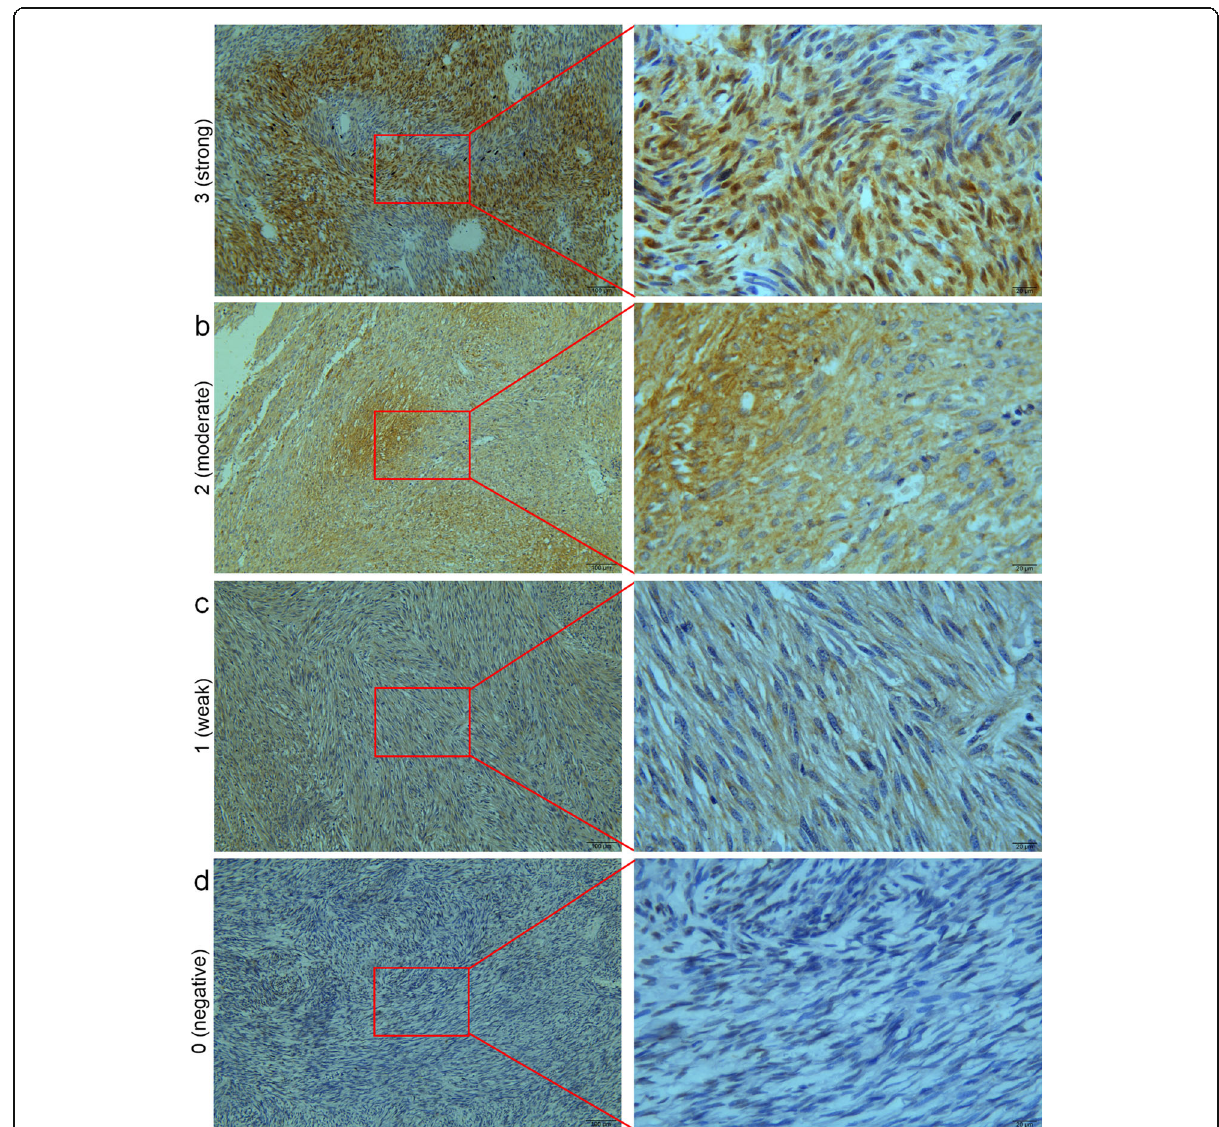
Fig. 1 Different staining intensities of SOCS6 in GIST tissues identified by immunohistochemical staining. A Strong staining intensity. B Moderate staining intensity. C Weak staining intensity. D Negative staining